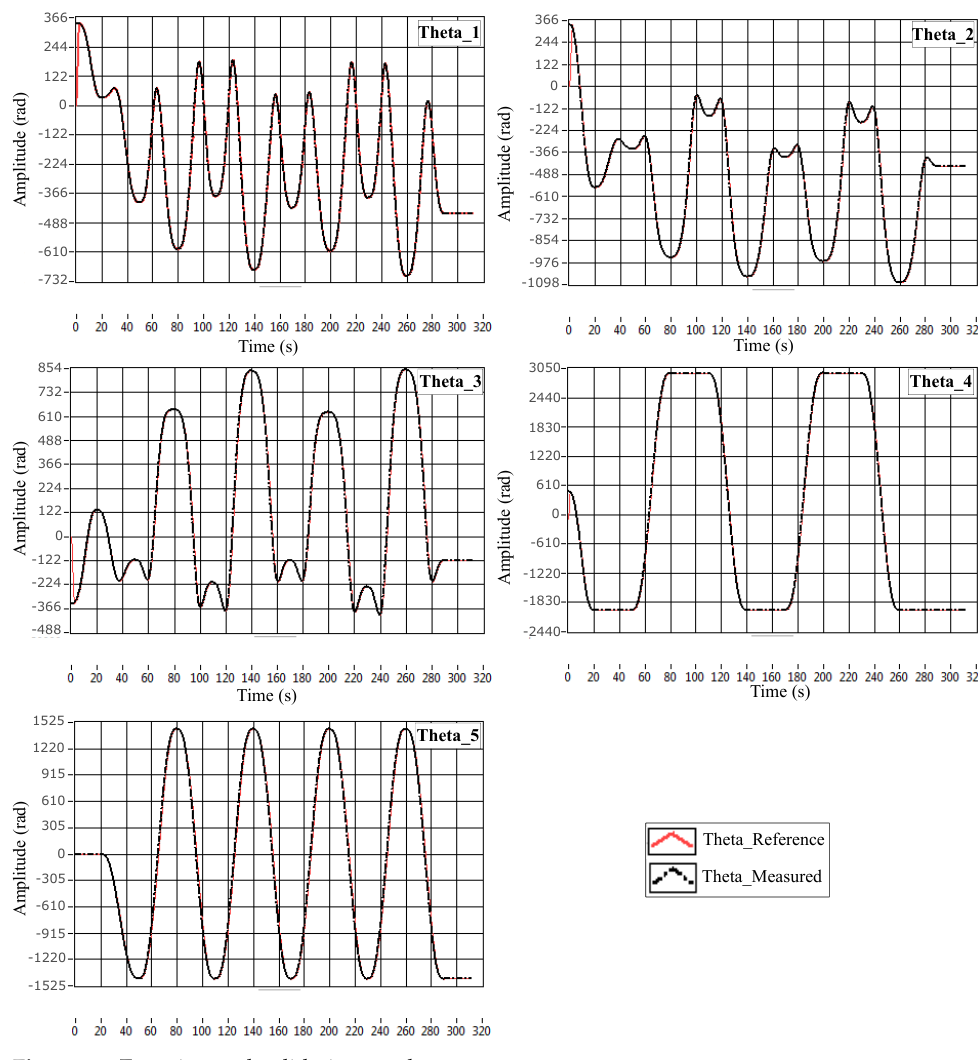
Figure 36. Experimental validation